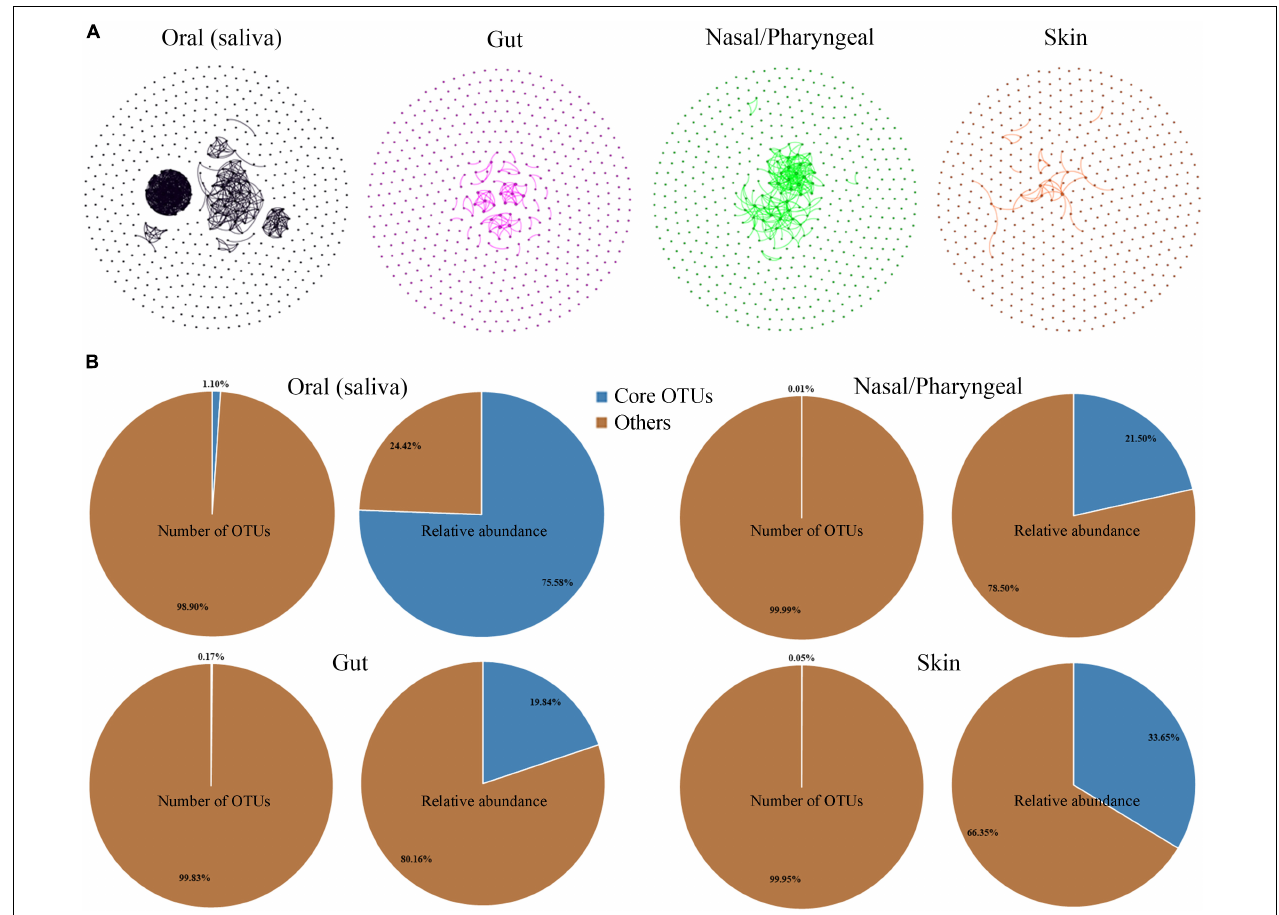
FIGURE 4 | Comparison of the dominant taxa and core taxa in the four habitats of human oral saliva, gut, nose/pharynx, and skin. (A) Co-occurrence network analysis of the dominant bacterial OTUs (top 500) of the different habitats. Each node represents an OTU, and the line indicates a significant correlation between the two OTUs (Pearson test, r > 0.5, p < 0.05). (B) Proportions of OTU number and abundance of core taxa in the four habitats of human oral saliva, gut, nose/pharynx, and